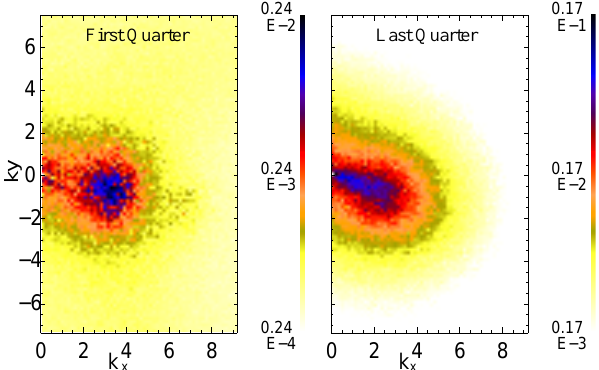
n i (k x ,k y ,t)dt for the first fourth Fig. 4. Spectra showing the R t 1 t 0 of the simulation ( t 0 = 0 ,t 1 = t final / 4 ) and the last fourth ( t 0 = t final ∗ 3 / 4 ,t 1 = t final ) . The logarithmic scale tends to deemphasize the strongest modes which in the right image are at small values of k